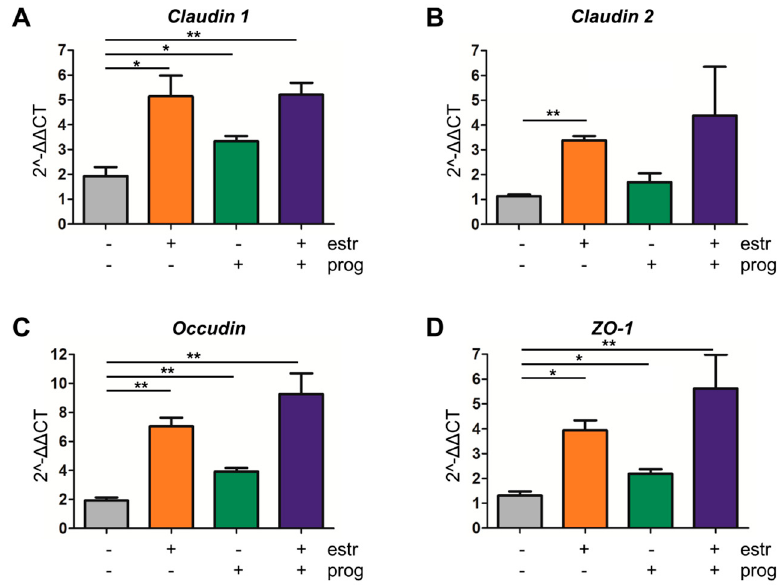
Figure 5. Improvement of tight junction dynamics by sex hormones. Quantitative PCR (QPCR) analysis of the tight junction claudin 1 ( A ), claudin 2 ( B ), ZO-1 ( C ) and occludin ( D ) were measured in the IBD organoid inflammation model. Co-stimulation with estrogen, progesterone, or a combination resulted in upregulation of claudin 1 , ZO-1 and occludin (three independent experiments). For claudin 2 this was only for co-stimulation with estrogen (five independent experiments). */** statistical significant ( p < 0.05)